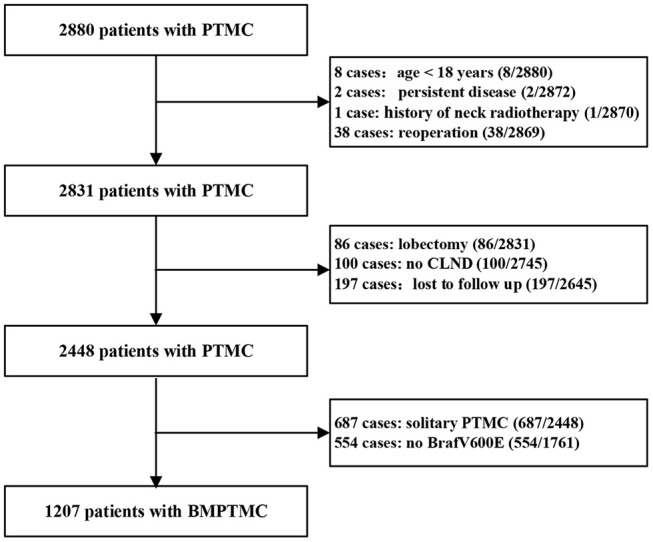
Flowchart showing patient selection.